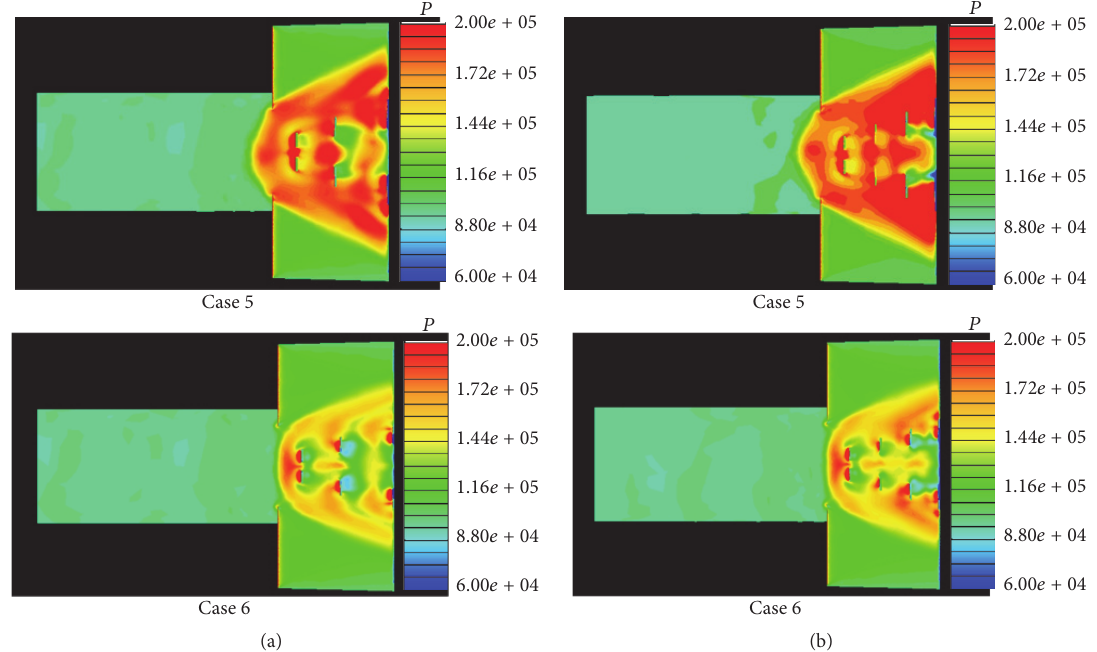
Figure 10: Computed surface pressure contours in the afterbody fin region near the microflaps, flap height variation, 𝑀 = 2.5, 𝛼 = 0 ∘ : (a) 6- and (b) 8-flap cases.